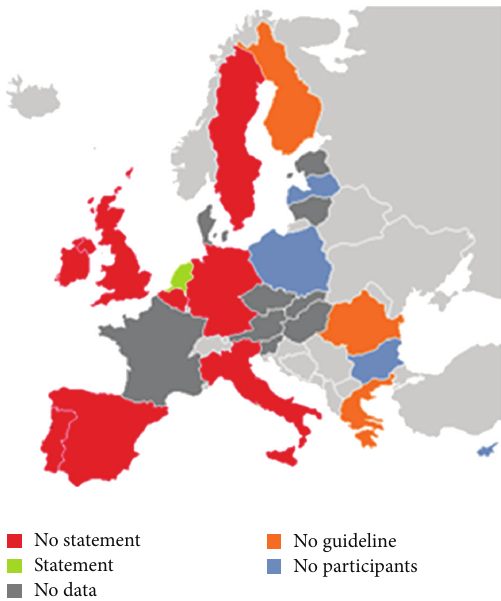
Figure 1: Responses to the following question: Were you aware that RSV bronchiolitis is found more often in children with DS? (A) indicatestheansweryes,Iwasaware.(B)indicatestheanswerno,but I have heard of the disease. (Missing data) indicates the percentage of participants who did not answer this question.